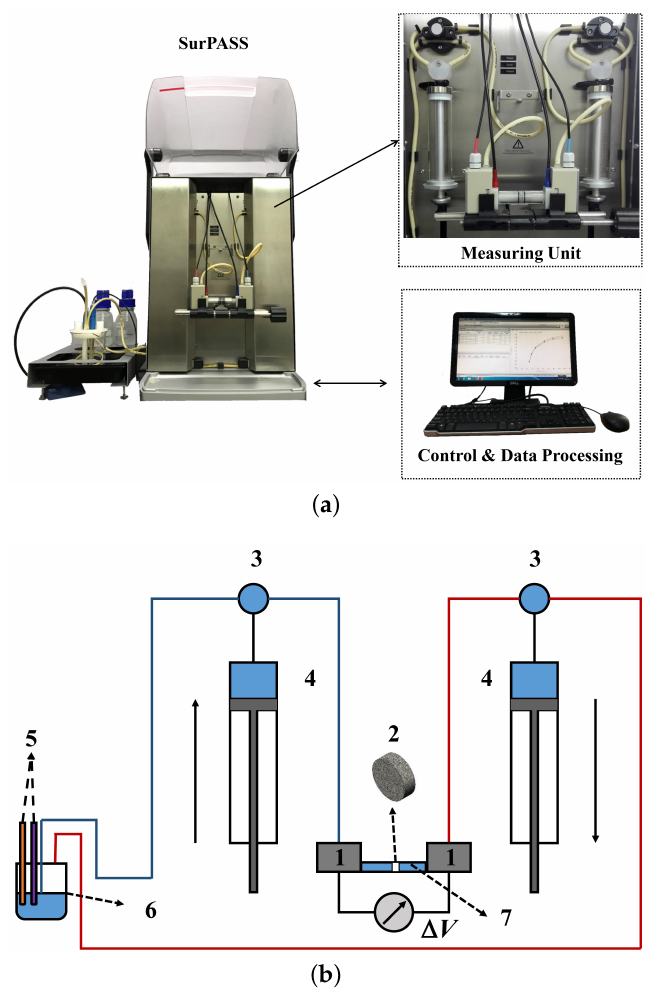
Figure 5. ( a ) Experimental apparatus SurPASS; ( b ) components of the measurement unit in SurPASS.